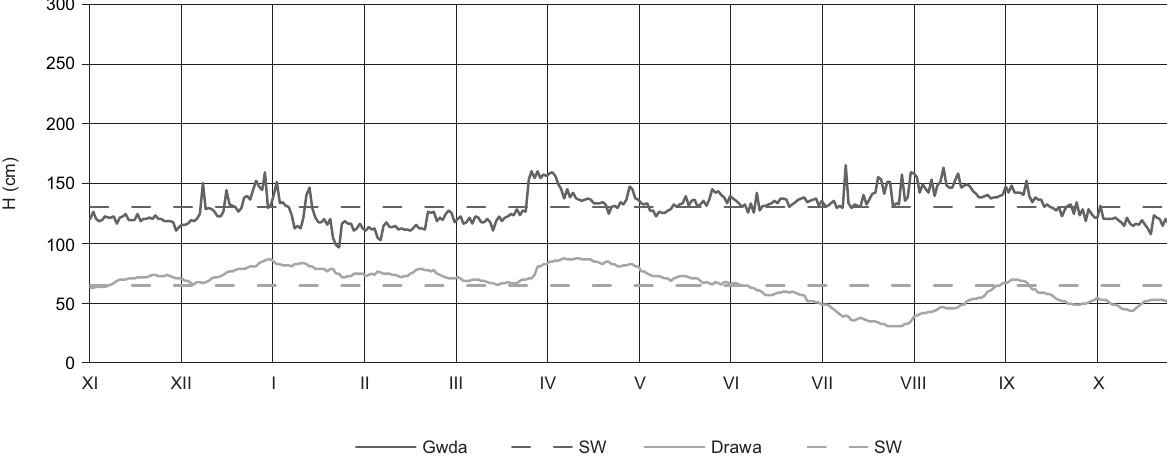
Fig. 5. Daily water stages of the Gwda River in Piła and the Drawa River in Drawiny in hydrological year 2006 (dry year)